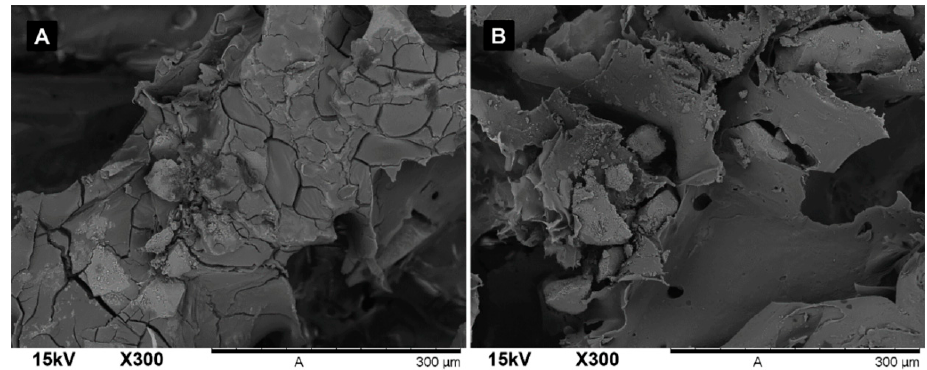
Figure 2. Scanning electron microscopy images of samples made of polylactic-co-glycolic acid (PLGA) and biphasic ceramic (HA + β -TCP) at a ratio of 60/40 in G2 with collagen ( A ) and 60/40 in G5 without collagen ( B ). ( A ) The ceramic particles within the matrix were covered by collagen, which created a bond holding the ceramic on the PLGA and resulting in higher mechanical properties. Isolated HA + β -TCP could be detected probably because of the sectioning of the samples by scalpel. ( B ) There is a lack of bond between PLGA and HA + β -TCP and ceramic scattered in the matrix is present. Magnification 150×.